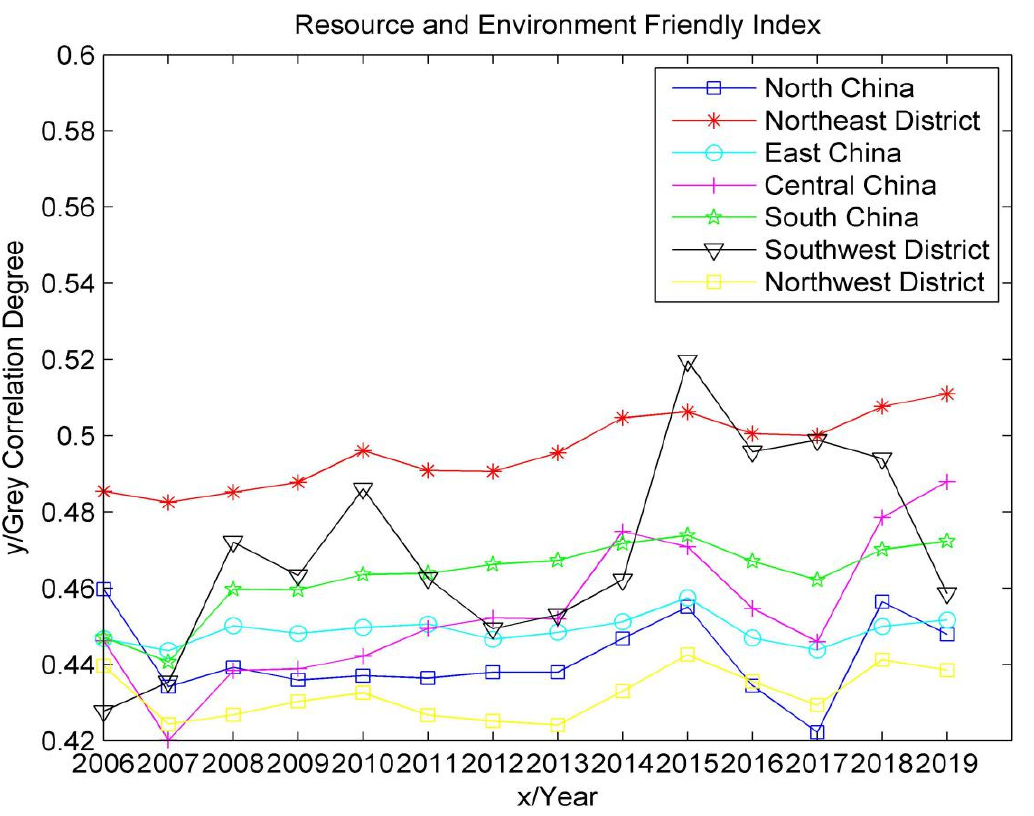
Figure 8. Time series change trend of environmentally friendly indicators of green agricultural